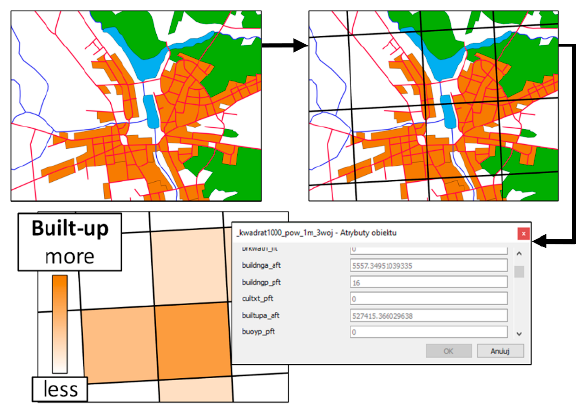
Figure 4 . Example of a vector model conversion to a grid for the built-up area feature class.